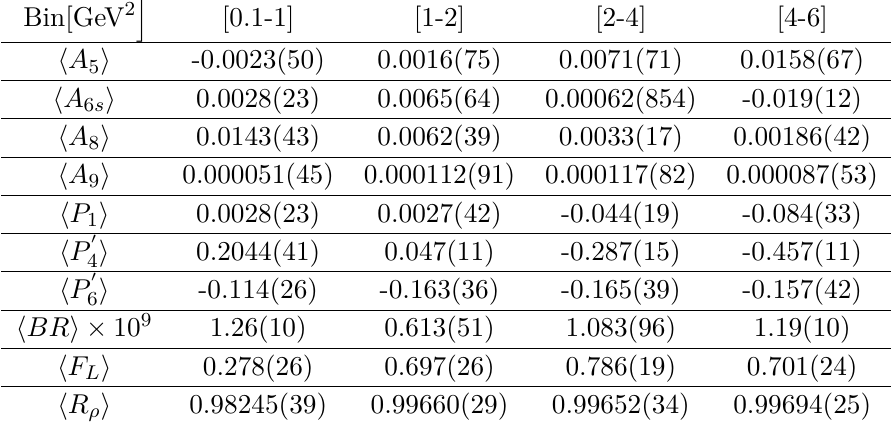
¯ B ( B ) → ρ 0 ‘‘ decays measurable at LHCb